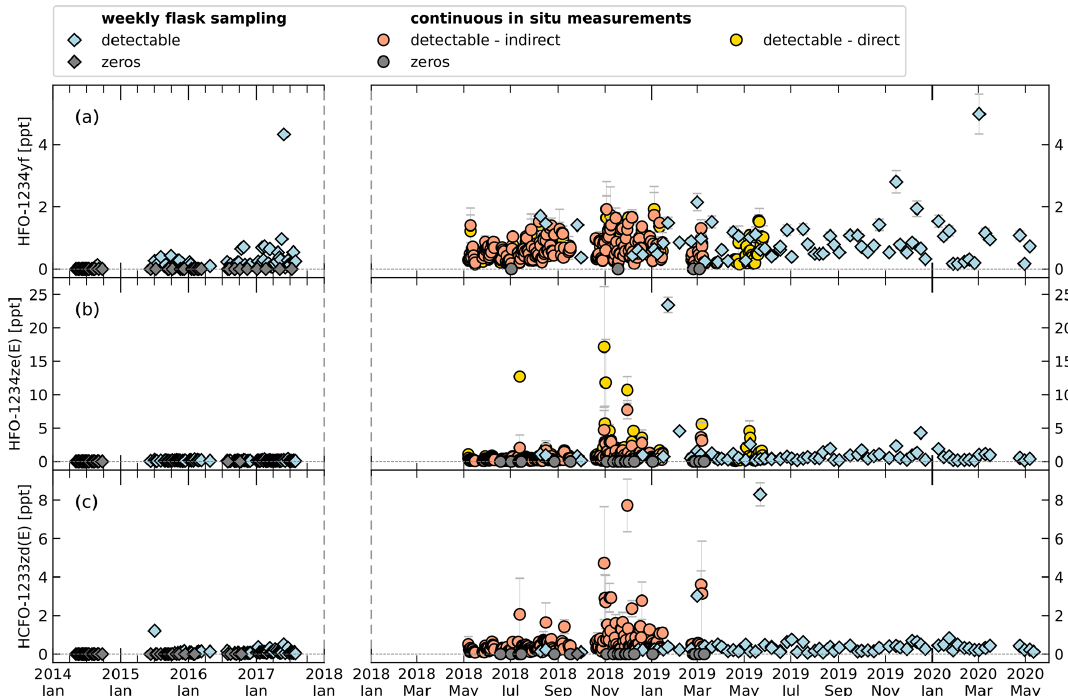
Figure 9. Time series of mole fractions of HFO-1234yf (a) , HFO-1234ze(E) (b) , and HCFO-1233zd(E) (c) at TOB. Symbol shape indicates flask sampling (diamonds) and in situ measurement (circles). Grey symbols represent mole fractions below detection limit (cf. Tables 2 and 3). Data of weekly flask sampling are indirectly calibrated mole fractions before January 2018 and directly calibrated values after. For the in situ measurements, indirectly and directly calibrated mole fractions are indicated by colour (orange and yellow). Note the change in x -axis scaling after January 2018 because of increased data frequency. Data of in situ measurements show daily means. Error bars for weekly flask sampling show the 1 σ standard deviation of the measurements for one sampling. Error bars for the in situ measurements show the standard deviation of the average of measurements over 1d.